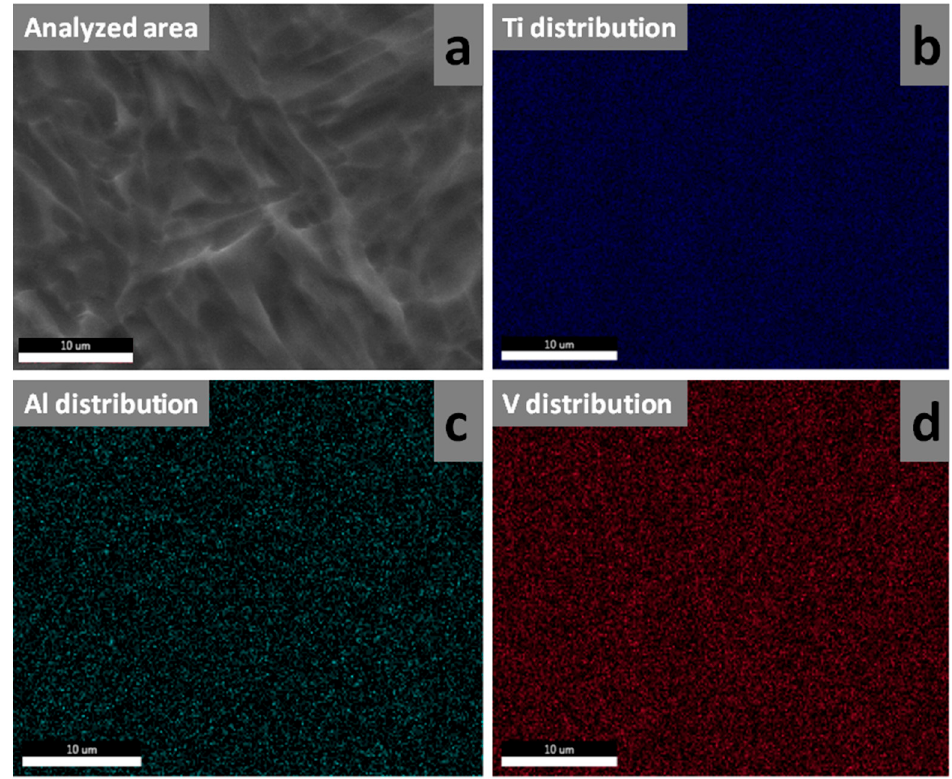
Figure 9. ( a ) SEM microscopic field selected for EDXS mapping. Elemental distribution maps for ( b ) Ti, ( c ) Al, and ( d ) V. Magnification bar: 10 µm.